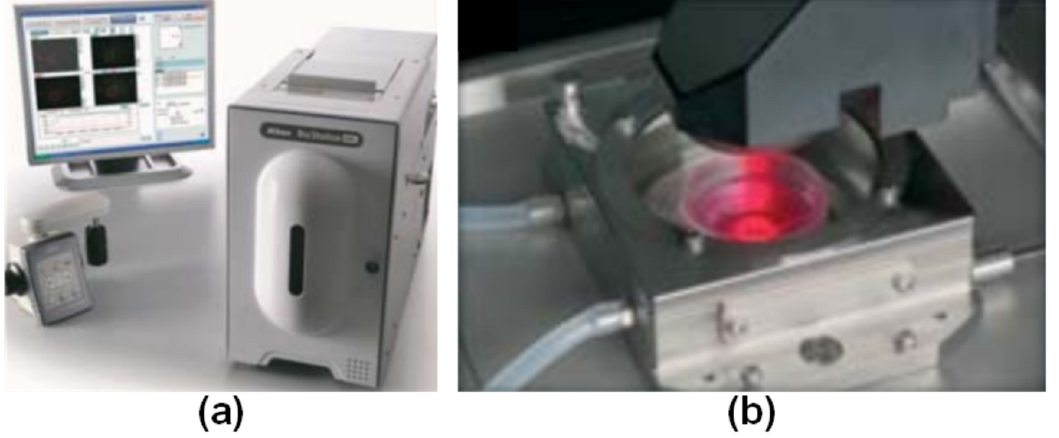
Fig 1. The Nikon BioStation IM benchtop live cell imaging system. (a) External features include a incubation unit, joystick for controlling the position of the camera during sample selection, and a monitor. (b) Culture dish sitting inside the BioStation IM incubator